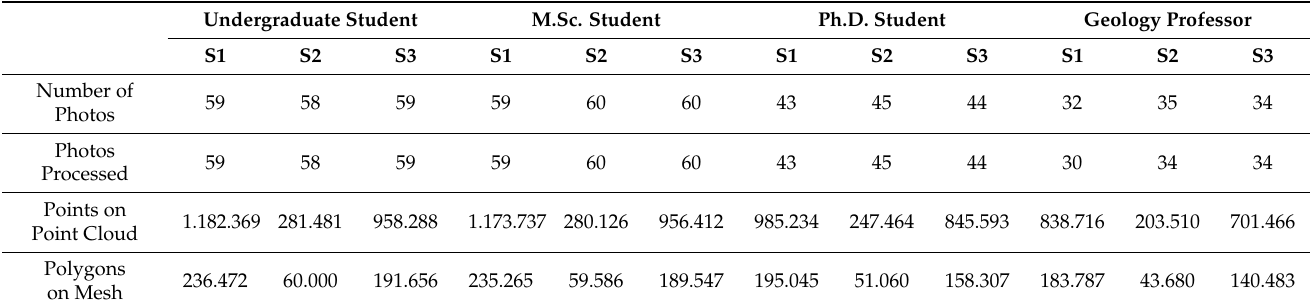
Table 3. Results of the first reconstruction previous to the complete methodological procedures.